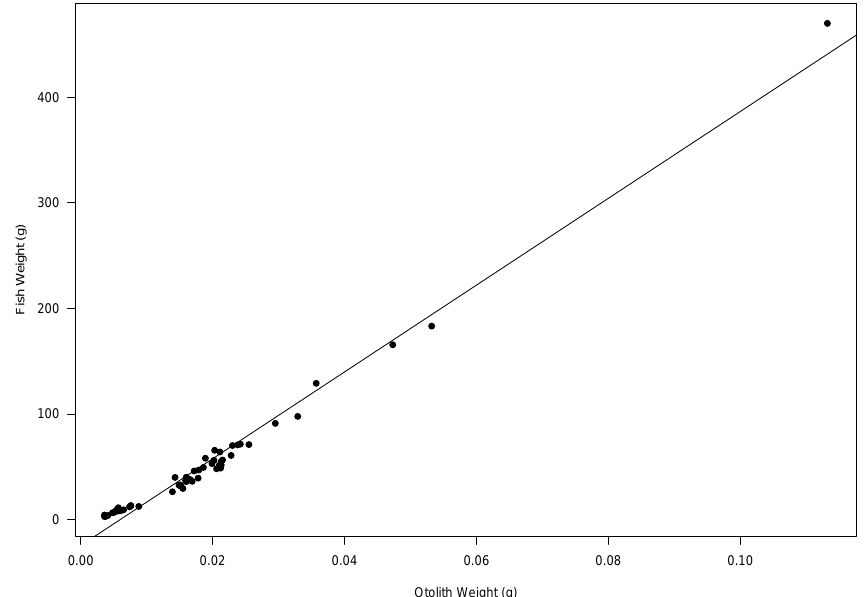
Figure 3. Relationship of L. harak otolith mass (g) to fish weight (g). Data are represented by the black dots and the line represents the model W = − 24.52 + 4110.93 O , where W and O represent individual weight and otolith mass,